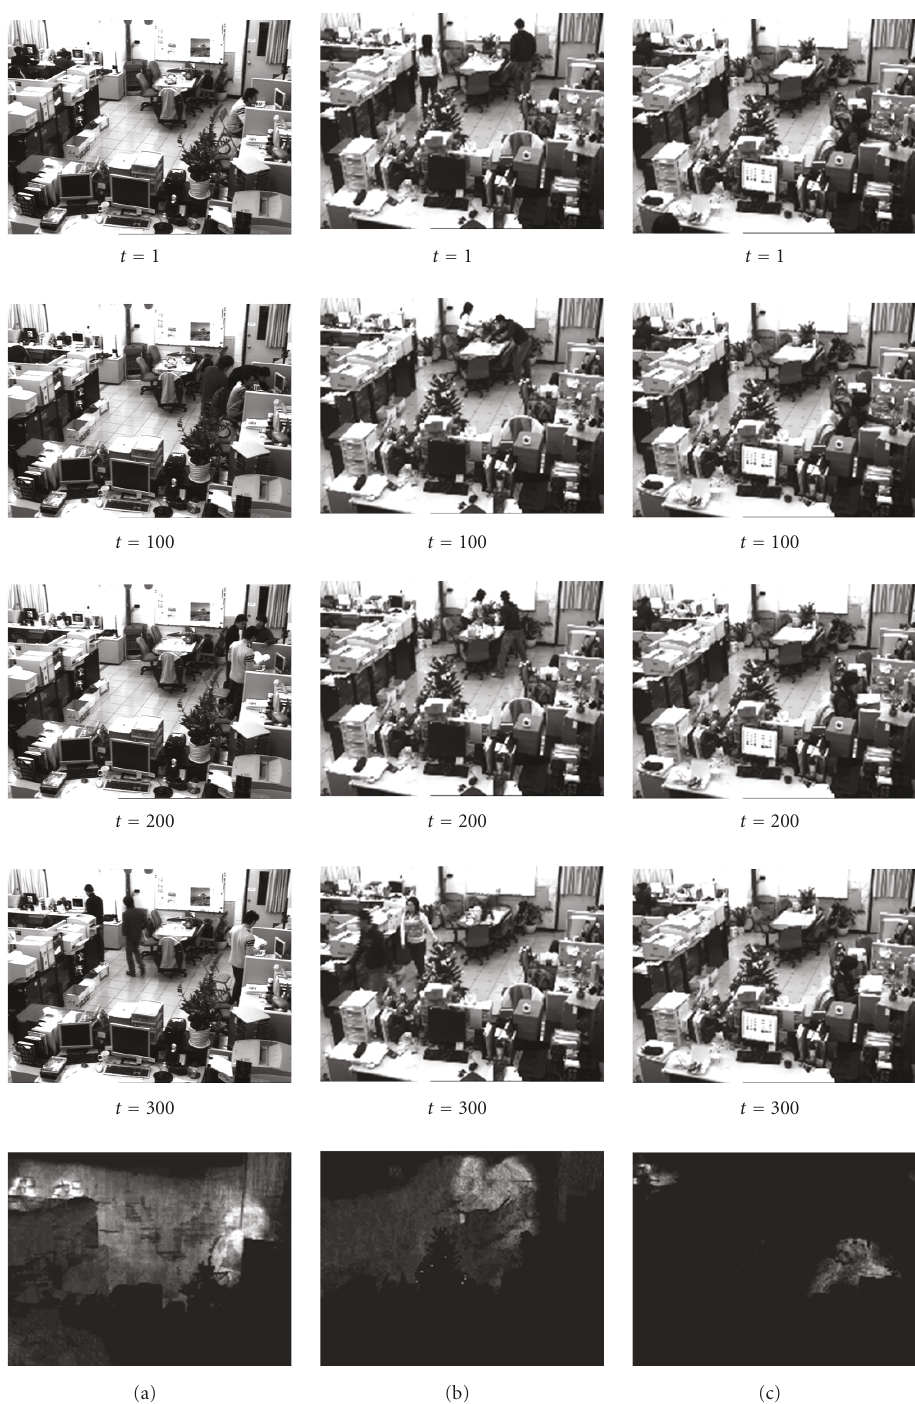
Figure 2: Video sequences involving di ff erent activities of multiple people and their corresponding energy maps: (a) a group of people discussing in the middle-right area; (b) multiple people chatting around the public desk; (c) multiple people working on the computers. The corresponding energy map of each column sequence is shown in the bottom